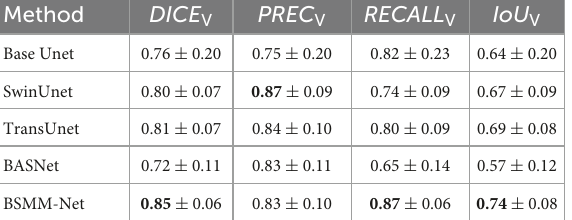
TABLE 2 Comparison of different models in volumes (3D).